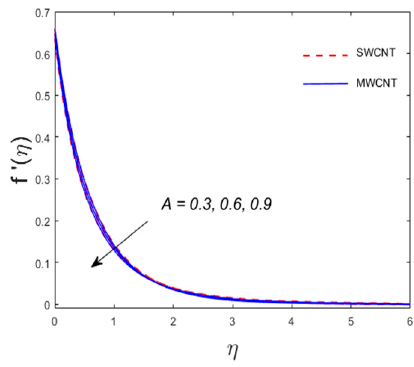
Figure 2. Outcome of 𝐴 vs. 𝑓′(𝜂) .